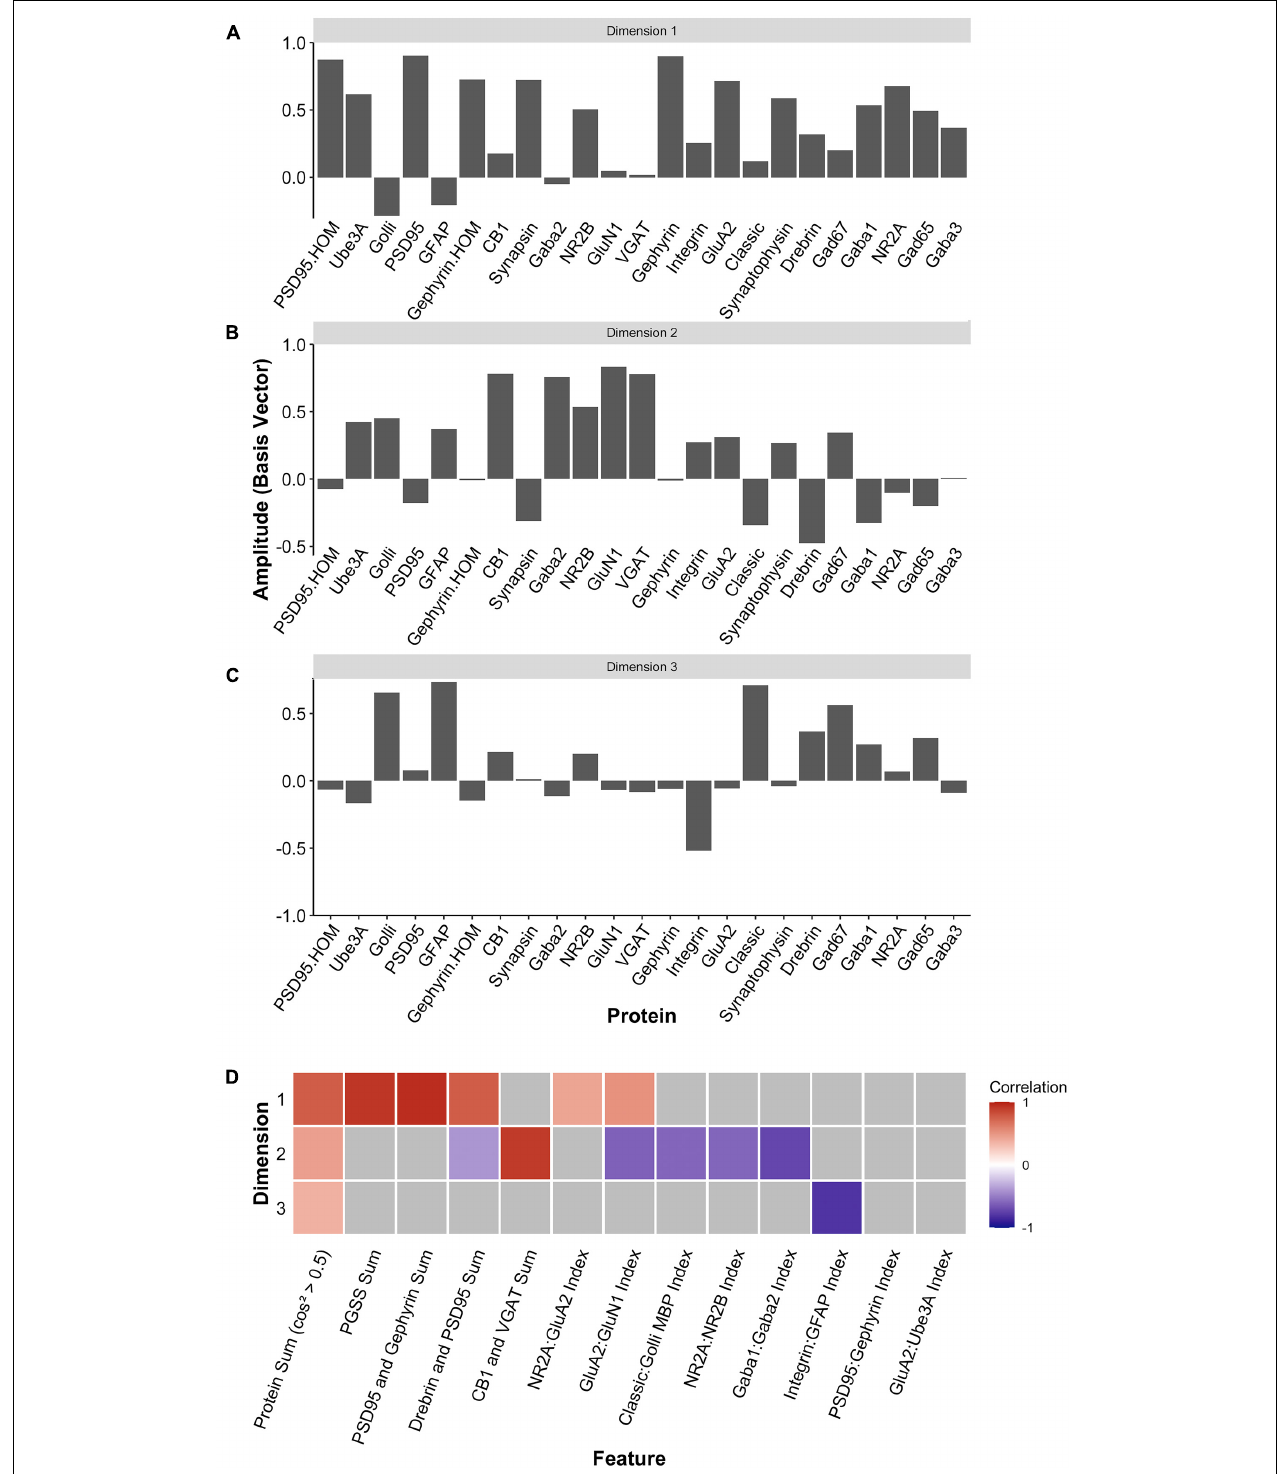
FIGURE 12 | Candidate feature identification using principal component analysis. Histograms showing the amplitude of the basis vector for each protein across (A) dimension 1, (B) dimension 2, and (C) dimension 3. (D) The correlations between the protein sums or indices and the first three PCA dimensions. Non-gray cells represent significant correlations after Bonferroni correction, with the color indicating the magnitude and direction of the correlation (negative = blue, zero = white, positive = red).